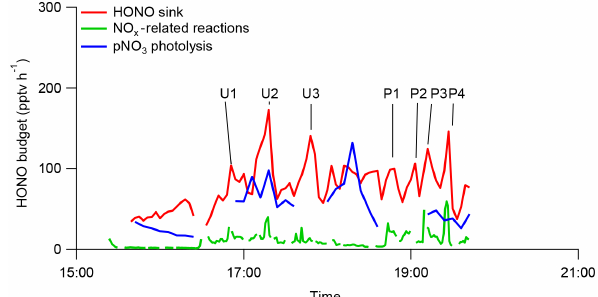
Figure 6. HONO budget analysis in RF 11 in the southeastern US during the NOMADSS 2013 summer study. “HONO sink” is the HONO loss rate contributed by photolysis and the reaction of HONO with OH radicals, “NO x related reactions” is the sum of HONO production rates from all known NO x reactions and “ p NO 3 photolysis” is the HONO production rate from photolysis of p NO 3 . The calculations are based on 1min NO x data, 3min HONO data and 6min p NO 3